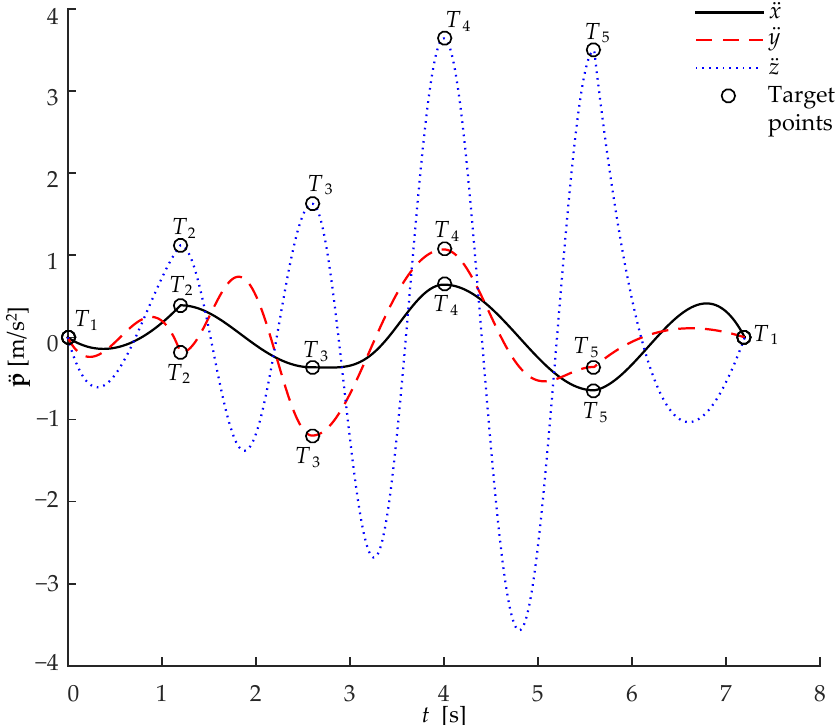
Figure 11. Plot of the acceleration components of P , for the Bézier curve trajectory.